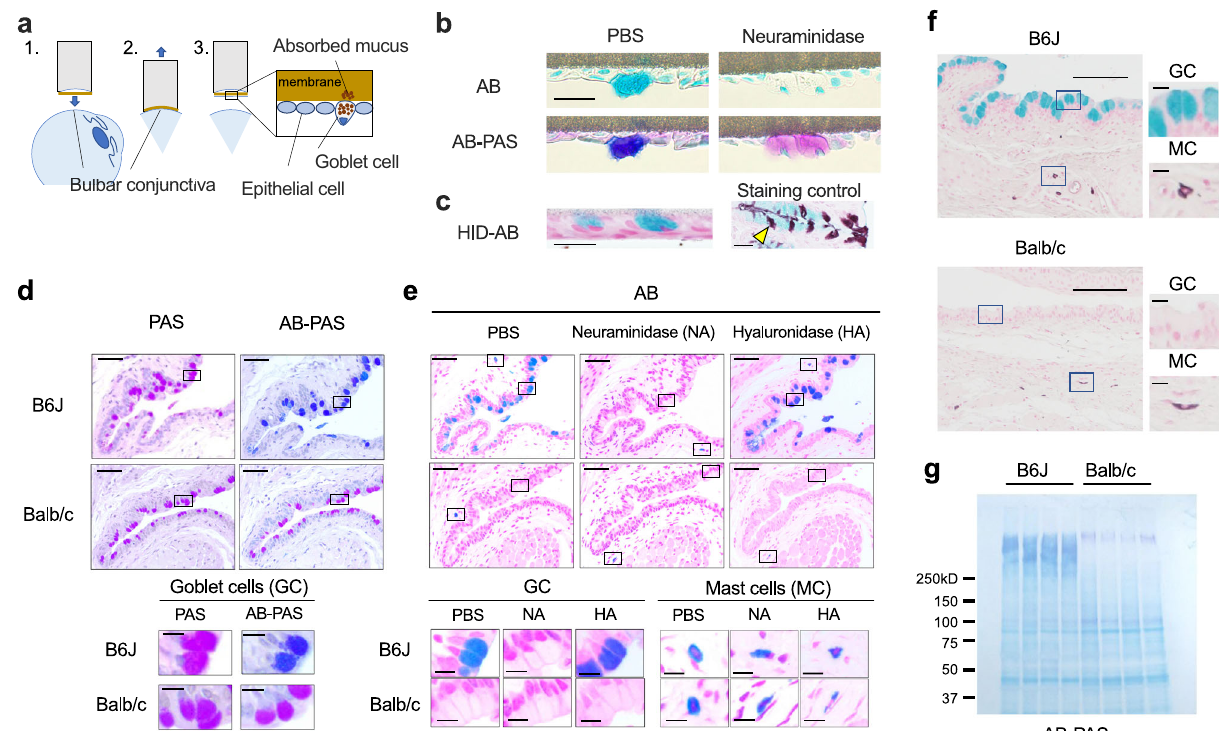
Fig. 1 | Conjunctival goblet cell mucus of humans and C57BL/6J mice, but not that of Balb/c mice, is sialylated in the steady state. a A schematic diagram of impression cytology. b Periodic acid – Schiff (PAS) and Alcian Blue (AB) (pH2.5) staining of the bulbar conjunctival goblet cells from healthy subjects with or without neuraminidase treatment. Bar, 20 μ m. c High-iron diamine (HID) and AB staining of sulfomucin of the human conjunctival goblet cells. Staining control: mouse colon. The arrowhead indicates an example of HID-positive (brown) goblet